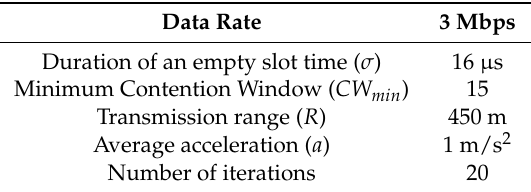
Table 2. Default parameter settings.